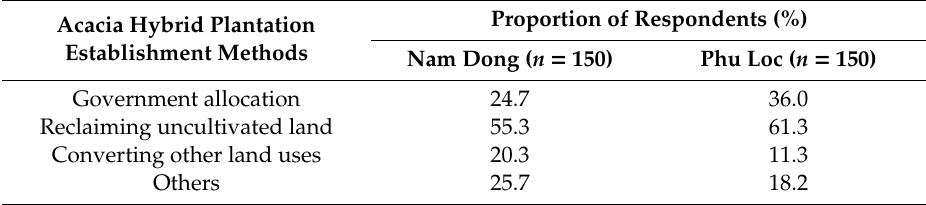
Table 3. Acacia hybrid plantation establishment ways in Nam Dong and Phu Loc